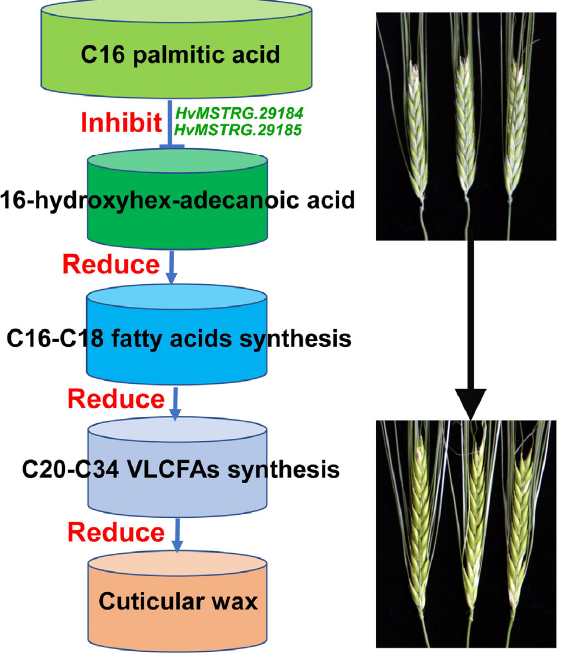
Figure 7. Simplified model for the function of novel genes HvMSTRG.29184 and HvMSTRG.29185 in regulating wax synthesis in the Cer-GN1 mutant. Downregulation of HvMSTRG.29184 and HvMSTRG.29185 would lead to the reduced accumulation of the predominant C16 and C18 fatty acid-derived 16-hydroxyhexadecanoic acid cutin monomer by inhibiting the conversion of the C16 of palmitic acid to 16-hydroxyhexadecanoic acid, which causes C16–C18 fatty acid synthesis, VLCFA synthesis and cuticular wax are decreased in the Cer-GN1 mutant.